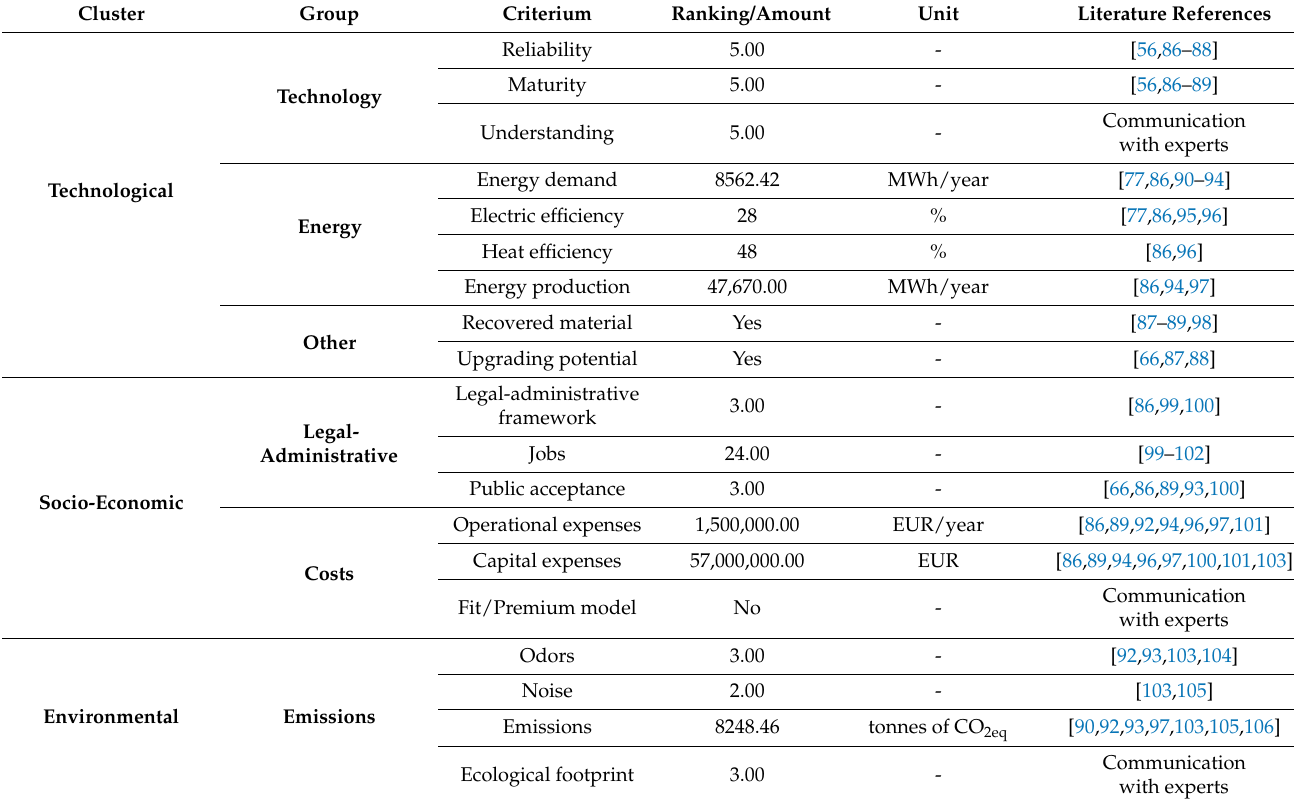
Table 5. Input data for the ranking of incineration